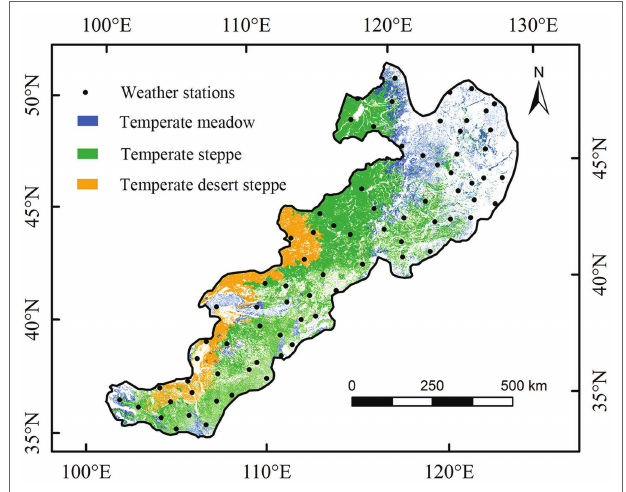
FIGURE 1 | Distributions of grassland vegetation and meteorological stations in China’s temperate